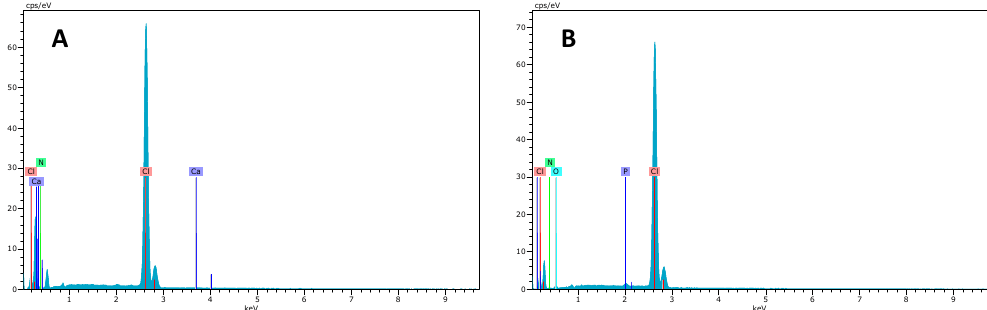
Figure 8. EDX analysis of membranes containing 70% w / w of IL after being used as separators for each feeding solution: CaCl 2 ( A ) and Na 2 HPO 4 ( B ).